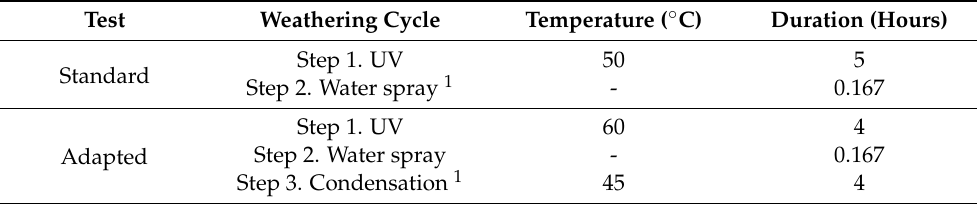
Table 2. Main characteristics of the weathering cycles.